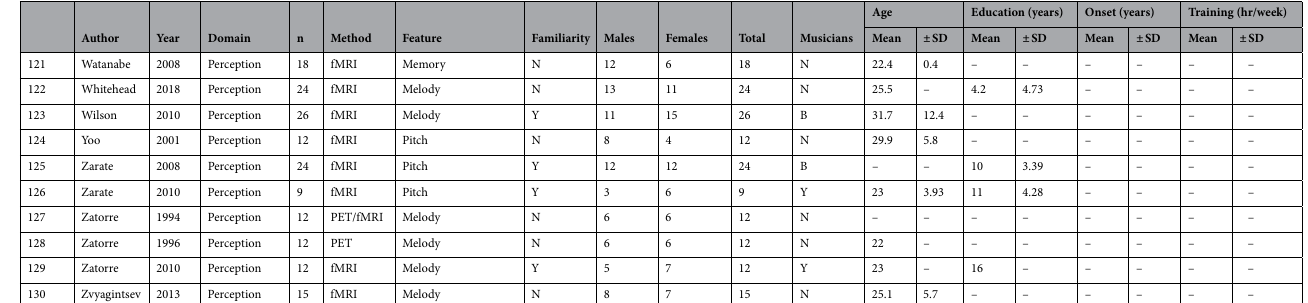
Table 1. Characteristics of the studies included in meta-analysis. Y yes, N no, B